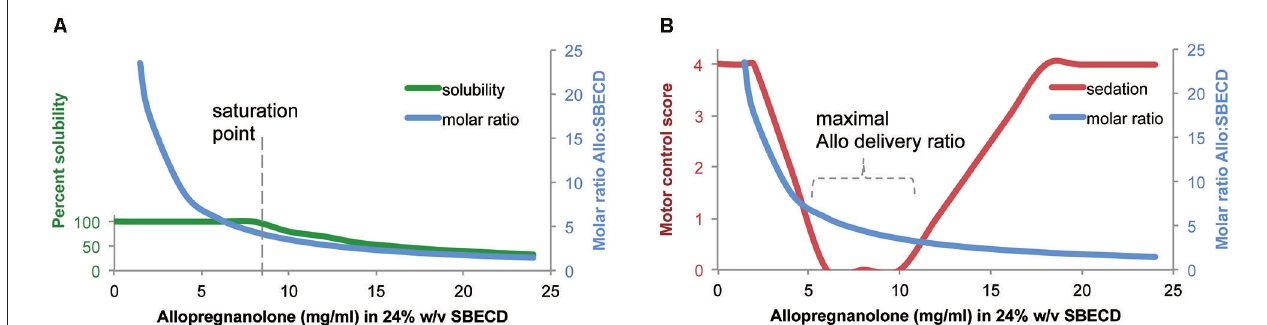
FIGURE 2 | Formulation of allopregnanolone matters . (A) Percent solubility of allopregnanolone (Allo) in 24% w/v SBECD. Allo reached an optimal formulation of 6:1 at Allo 6 mg/ml in 24% SBECD. Solubility began to decline, observed by precipitation, when Allo concentration was between 8–10 mg/ml coinciding with a molar ratio of between 4–5 SBECD molecules per Allo molecule in water at room temperature without pH adjustment. (B) Motor control/sedation at 25 min after subcutaneous Allo 8 mg/kg to male rats measured by balance beam task on a five point scale where 4 = reaches platform; 3 = takes steps; 2 = all paws on top; 1 =